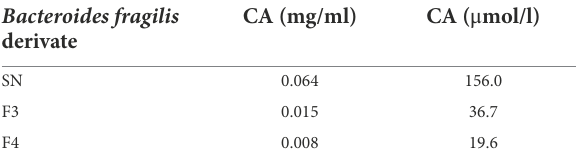
TABLE 2 Cholic acid (CA) quantification in supernatant (SN) and in bioactive fractions (F3, F4) after HPLC-ELSD (High-performance liquid chromatography- evaporative light scattering detector) analysis.